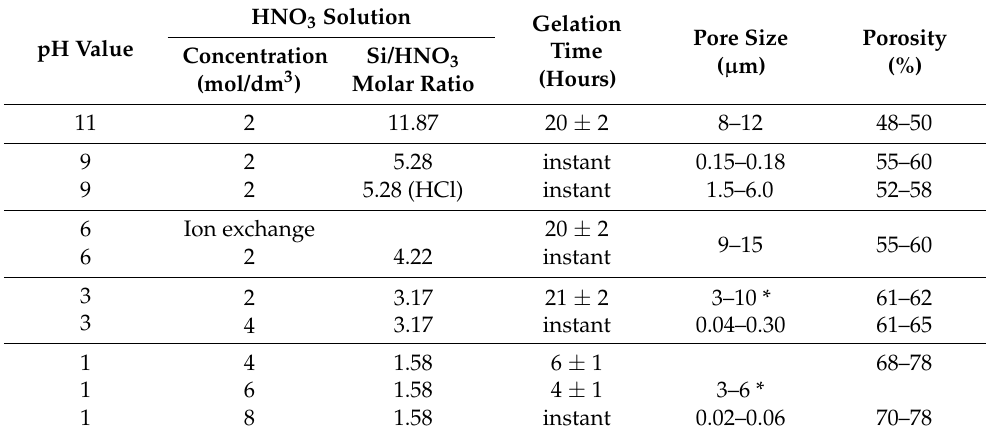
Table 2. The effect of pH on the gelation time and porous structure.